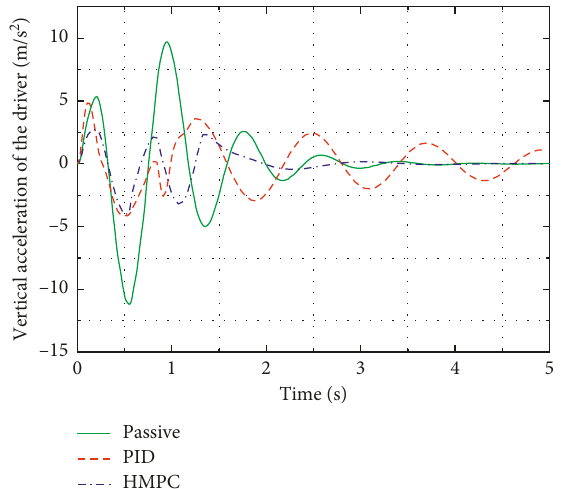
Figure 8: Suspension deflection under random input. Table 4: RMS value comparison under random road input.